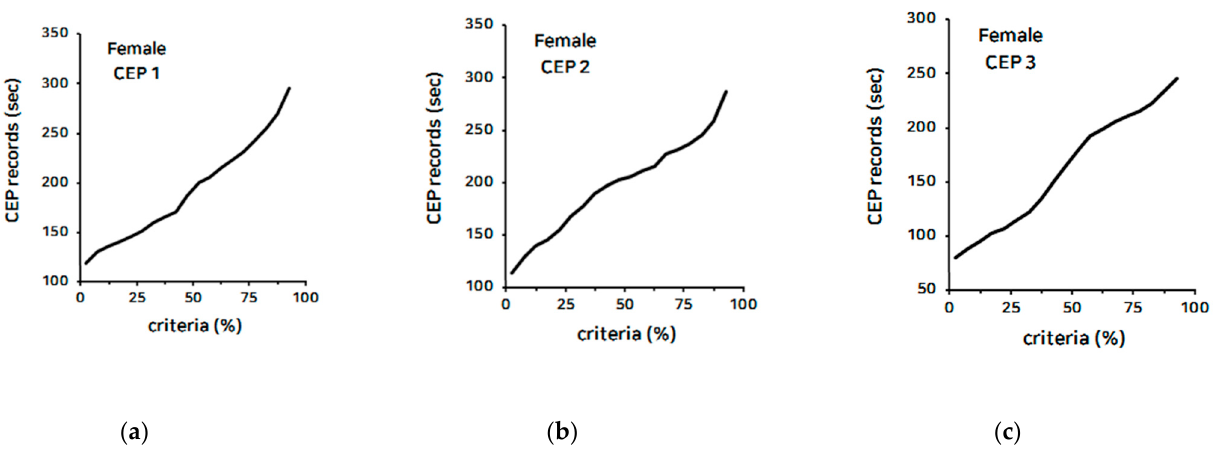
Figure 1. The criteria of circuit exercise program for males: ( a ) circuit exercise program 1; ( b ) circuit exercise program 2; ( c ) circuit exercise program 3.